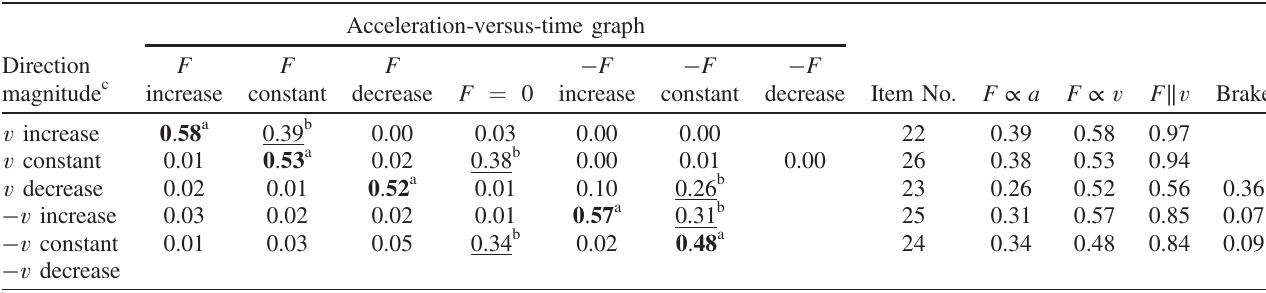
a The corresponding proportions of the F ∝ v model are shown in Table VIII in bold type.